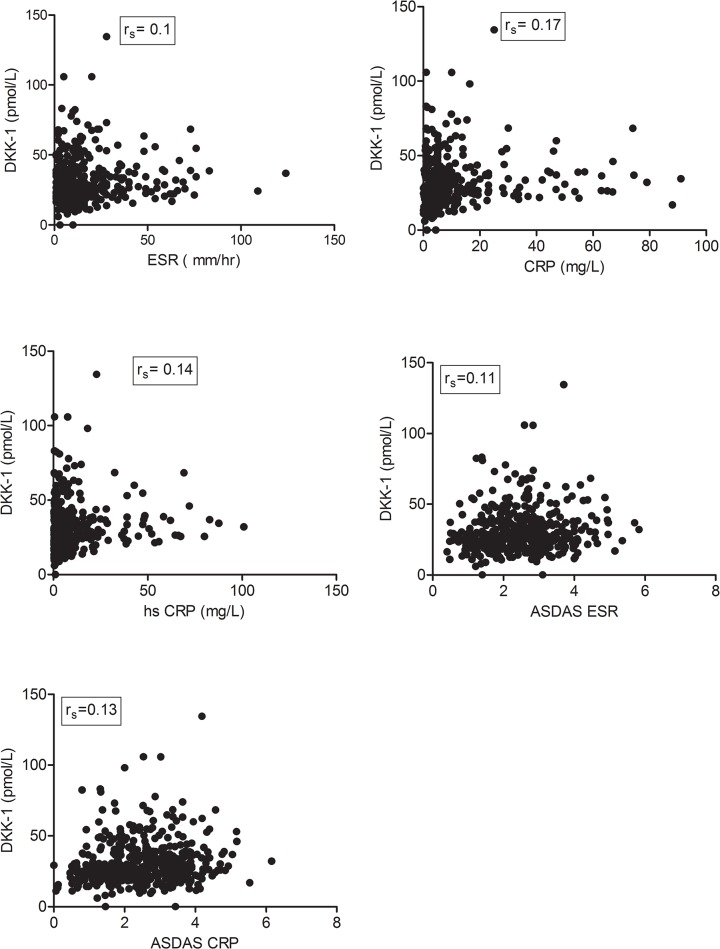
Correlation of DKK-1 serum level with systemic inflammation assessed by ESR.(A) (rs = 0.1, p = 0.03), CRP level (B) (rs = 0.17; p = 0.0001), hs-CRP level (C) (rs = 0.14; p = 0.003), Ankylosing Spondylitis Disease Activity Score (ASDAS)-ESR (D) (rs = 0.11; p = 0.02) and ASDAS-CRP level (E) (rs = 0.13; p = 0.004); rs: Spearman correlation coefficient.